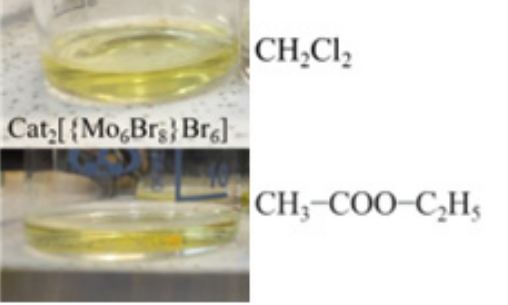
Figure 2. Demonstration of the solubility of the catalyst in dichloromethane and ethyl acetate.